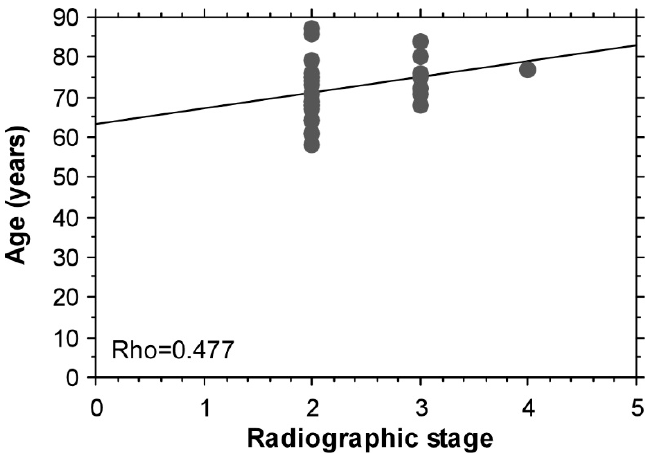
Figure 5. A correlation between age and radiographic stage of the knee OA in patients with BMI < 30 kg/m 2 .